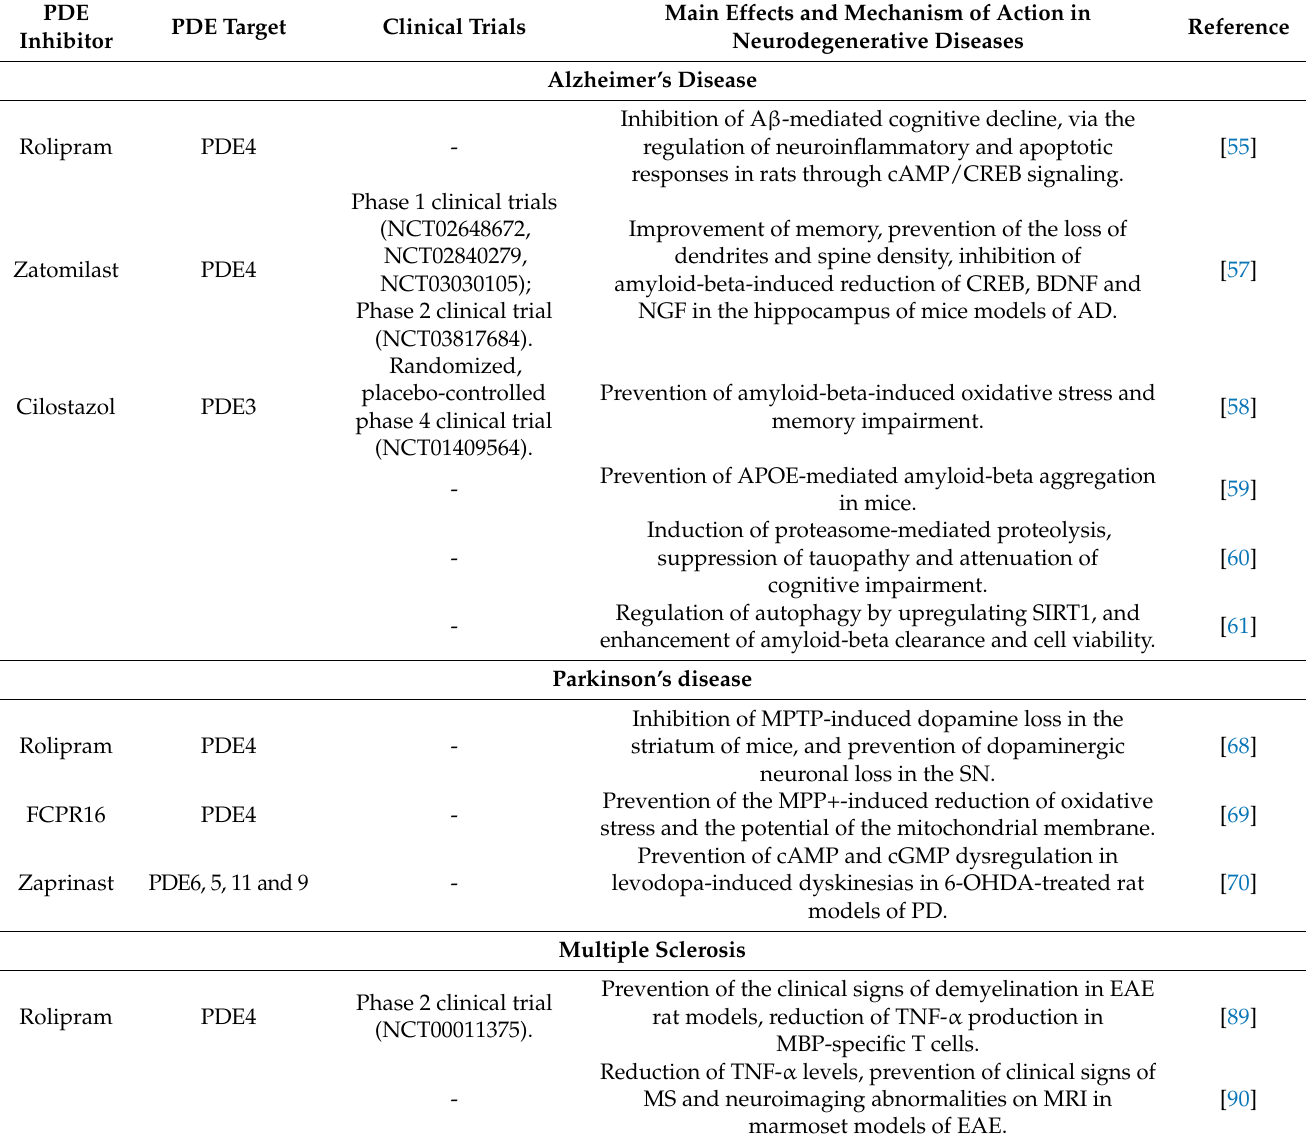
Table 2. Preclinical or clinical evidence on different PDE inhibitors—other than ibudilast—for neurodegenerative diseases, their PDE targets and main mechanisms of